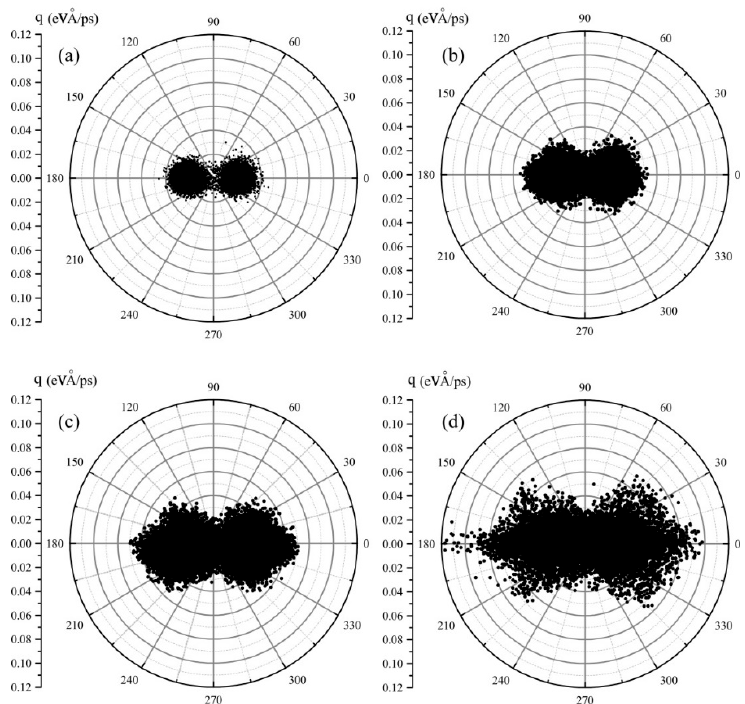
Figure 6. Angle distribution of atomic heat flux vectors in fractal graphene. ( a ), ( b ), ( c ), and ( d ) represent the fractal level numbers 0, 1, 2, and 3.